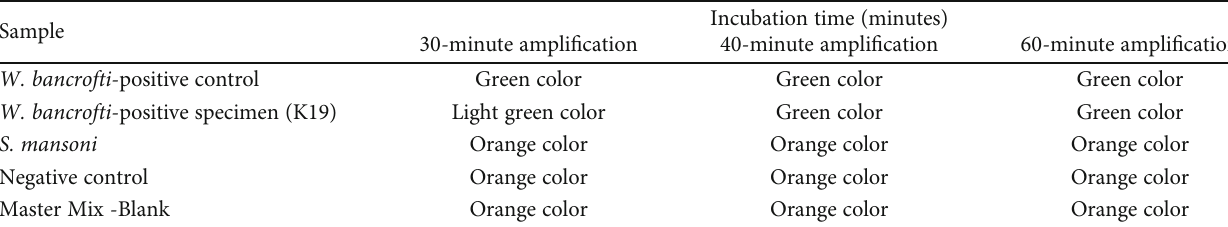
Table 2: Time-dependent